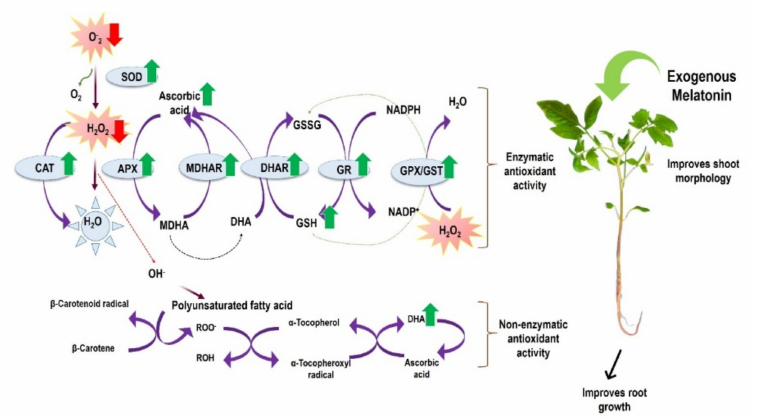
Figure 11. A proposed model showing how melatonin mitigates drought stress tolerance in tomato seedlings.